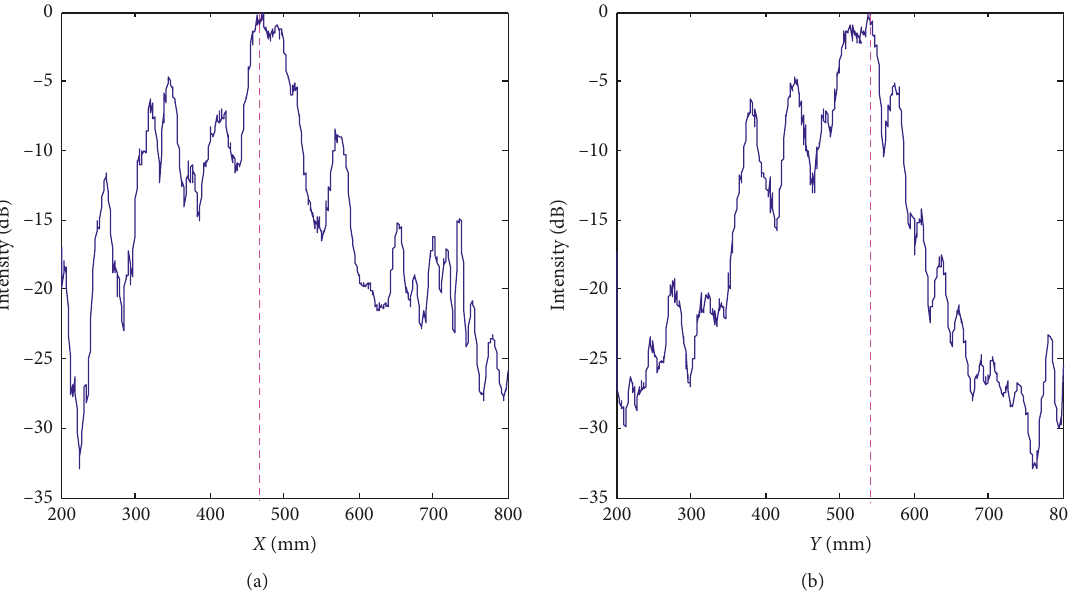
Figure 16: TDTE imaging intensity profile in (a) the X direction of the point (468 mm, 552mm) and (b) Y direction of the point (468 mm,